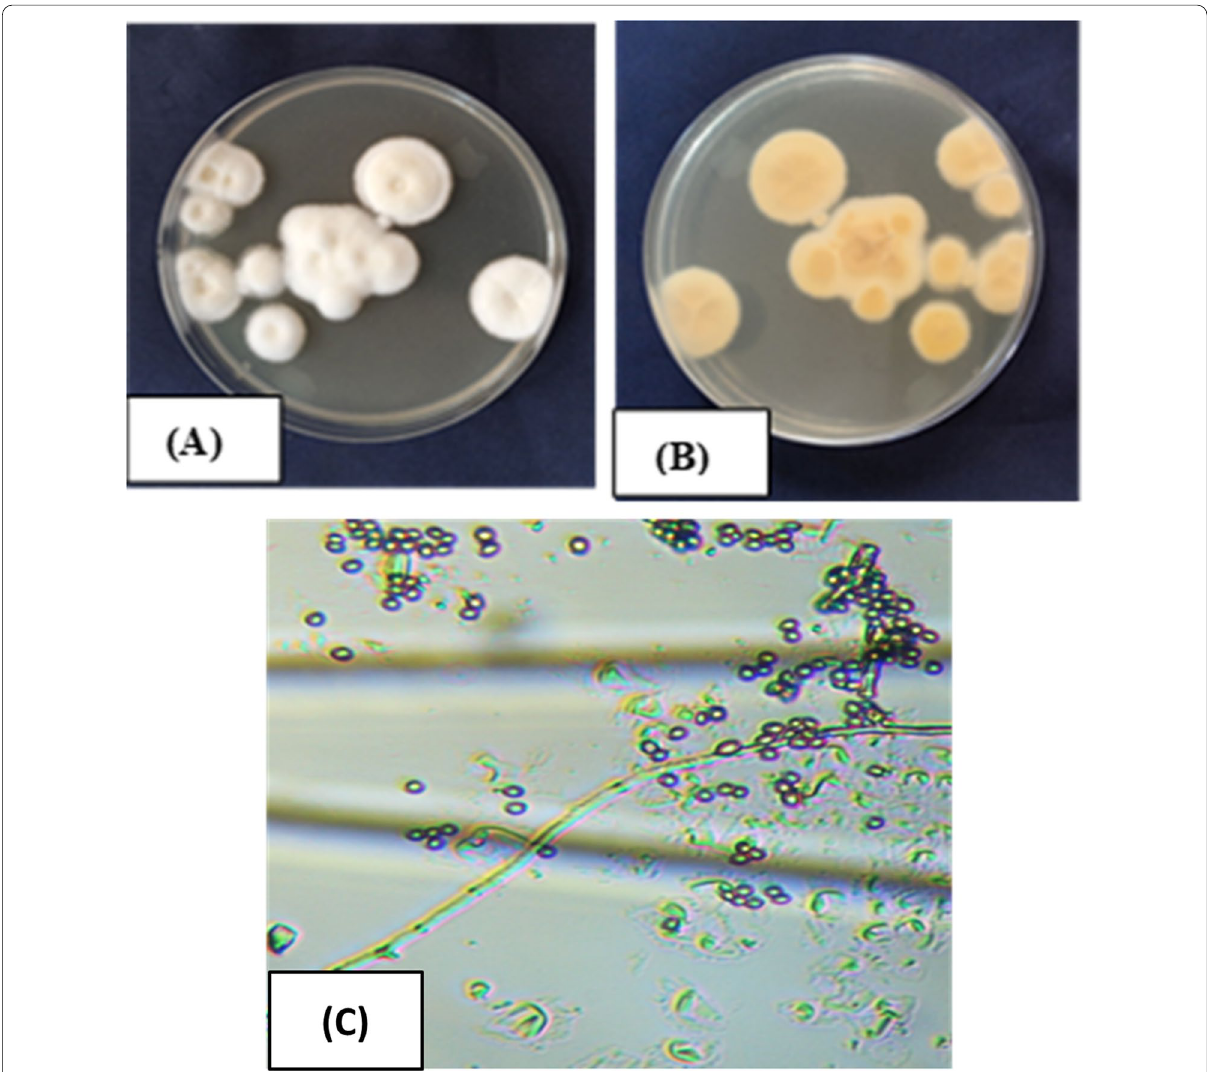
Fig. 1 Morphological characters of Beauveria bassiana A , B B. bassiana cultured on PDA medium at 25 reverse side C Conidia were hyaline single celled, globose, and smooth